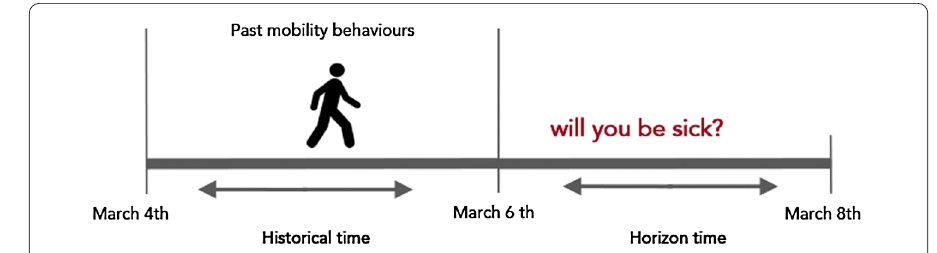
Figure 3 Example of problem setting with t hist = 2 and t hor =